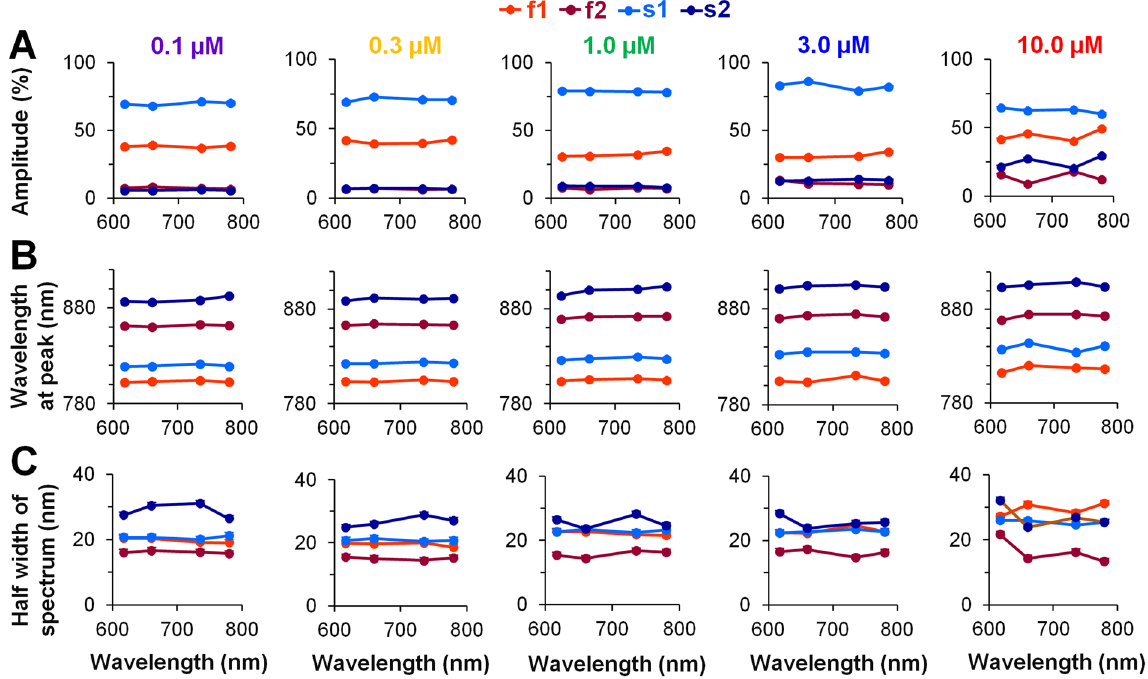
Figure 4. The mean values of Gaussian lineshape parameters for each of the four constituents at various concentrations of the ICG dye. ( A – C ) The indicated points in all graphs correspond to excitation at wavelengths of 617 nm, 660 nm, 735 nm, and 780 nm. Each of the four Gaussian constituents (two for fast (f1 and f2; shown in red and dark red , respectively) and two for slow (s1 and s2; shown in blue and dark blue , respectively)) is associated with three parameters: the amplitude ( A ), the wavelength at fluorescence maximum ( B ), and the half width of the spectrum at 50% of the fluorescence maximum ( C ). These parameters were measured using five different concentrations of the ICG dye ranging from 0.1 to 10.0 µ M (n = 3–9 for each concentration). Error bars indicate